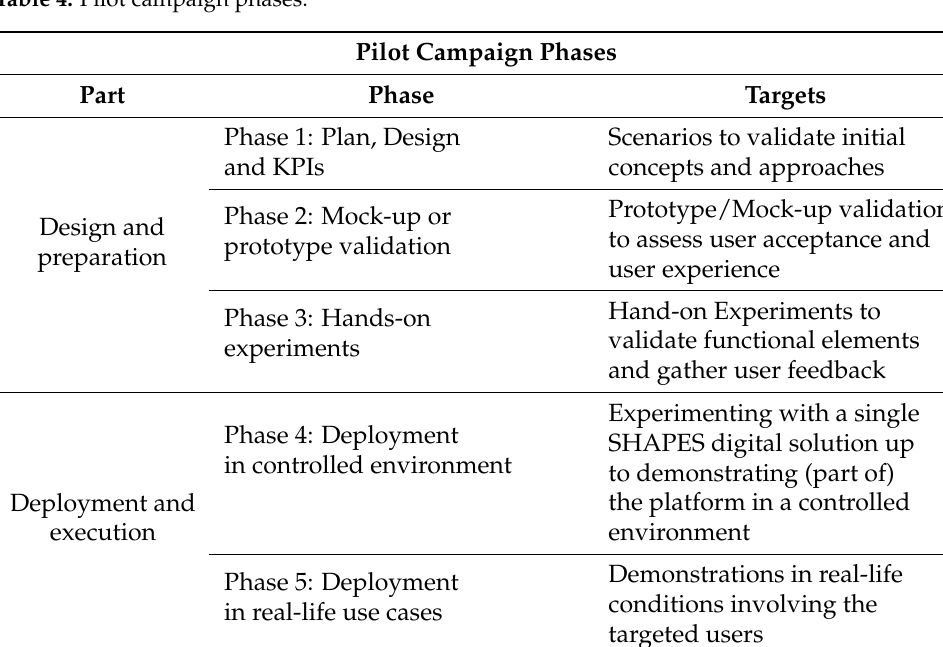
Figure 2. Use cases timeline defined in the SHAPES methodology. Table 4. Pilot campaign